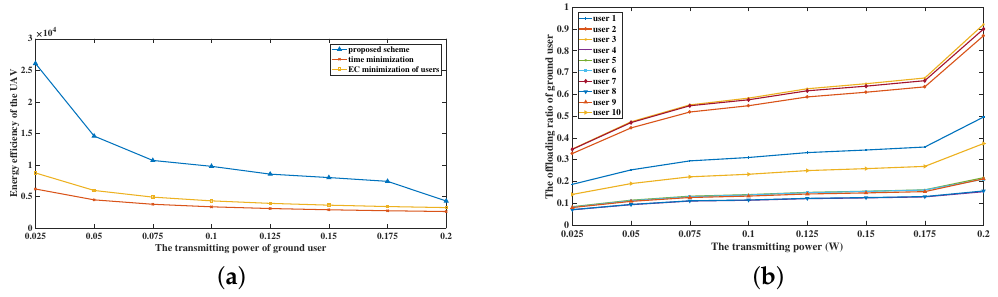
Figure 5. The performance of the UAV under different transmitting power. ( a ) Energy efficiency of the UAV with different transmitting power; ( b ) Offloading ratio of ground users with different transmitting power under the proposed